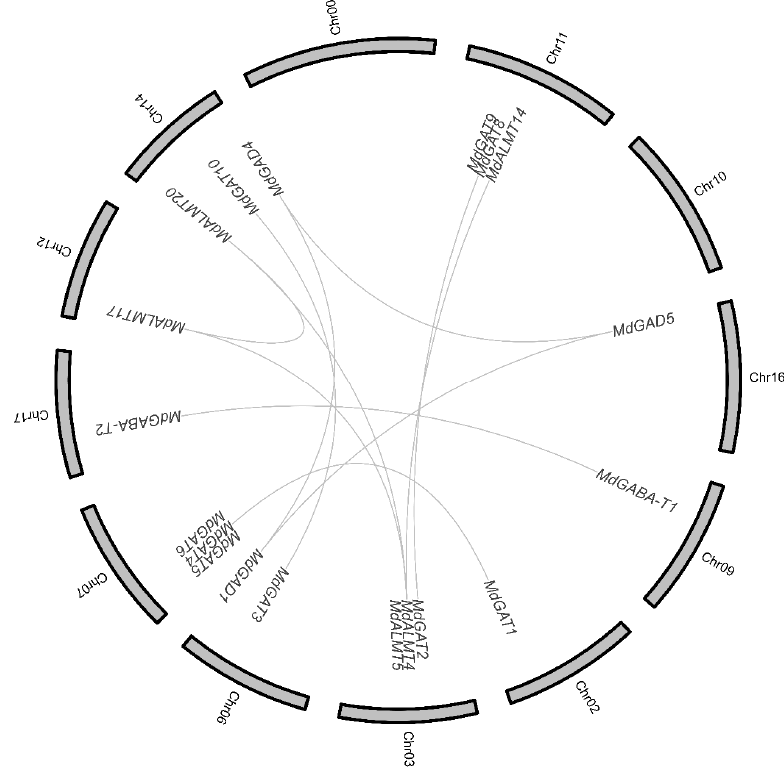
Fig. 2. Collinearity analysis of GABA pathway genes in apple. Figure 2. Collinearity analysis of GABA pathway genes in apple. Ten pairs of paralogous GABA pathway genes were identified and distributed on different chromosomes in apple, whereas no tandem duplication events were observed, suggesting that segmental duplications were the main causes for the amplification of GABA pathway gene